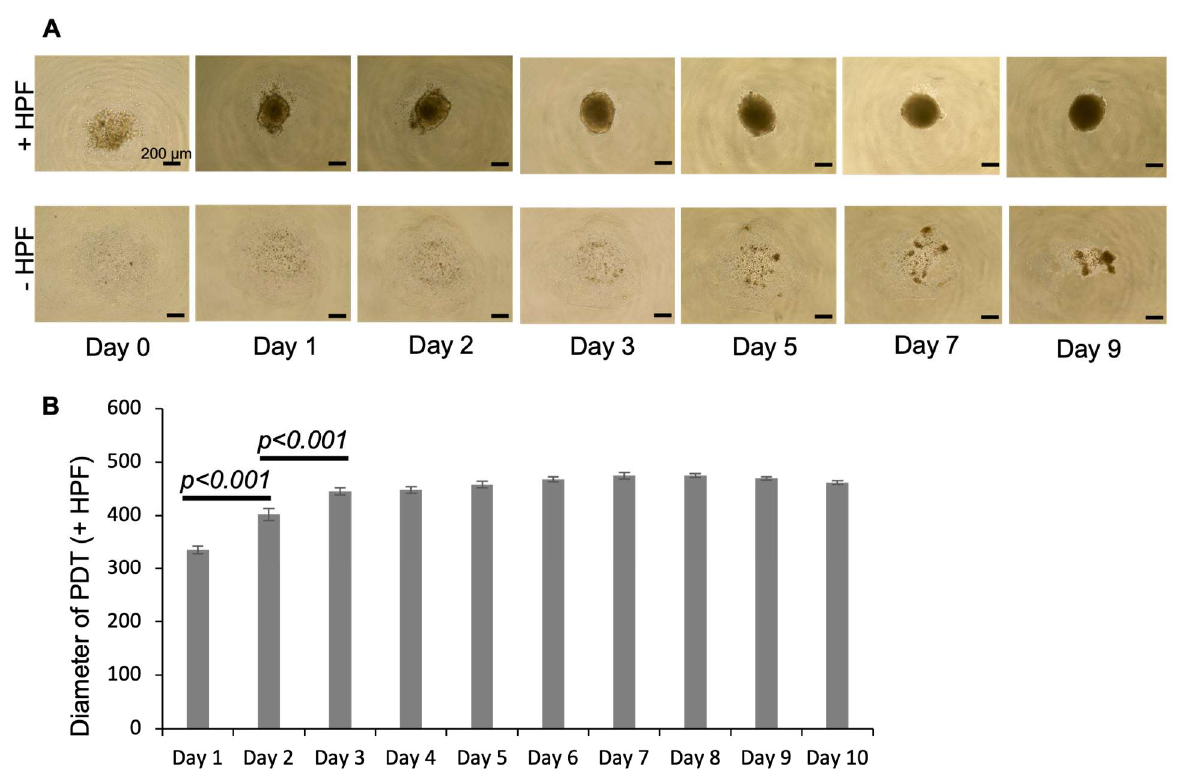
Figure 1. Formation of patient-derived tumoroids (PDTs). ( A ) Daily microscopic observation of the PDTs with or without HPF cells. ( B ) The diameter of 24 PDTs were measured every day using FIJI software (Version: 2.0.0-rc-69/1.52p). Measurements were repeated for PDTs formed from three bi- opsies.